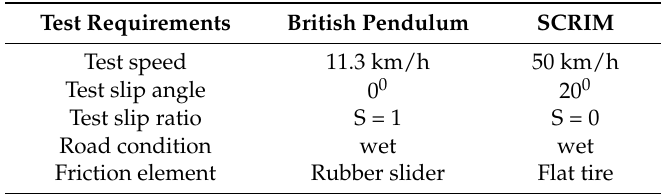
Table 6. Test conditions in the devices to measure the friction resistance.